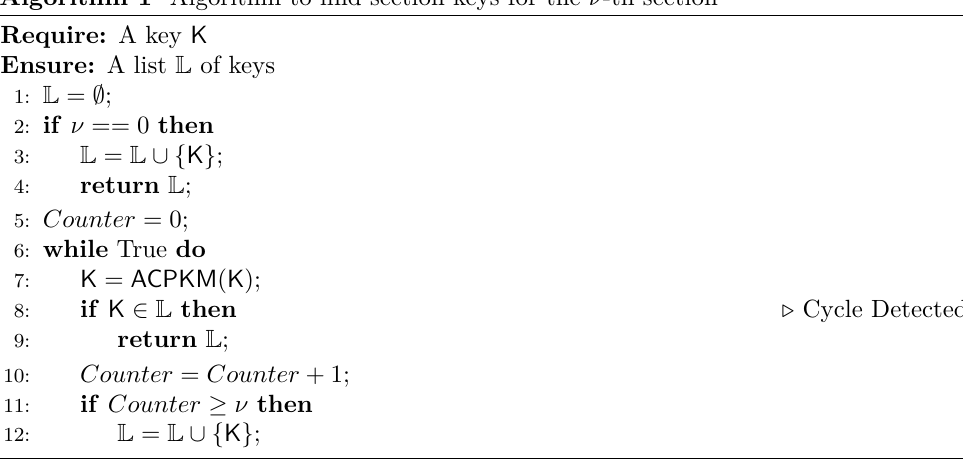
Algorithm 1 Algorithm to find section keys for the ν -th section